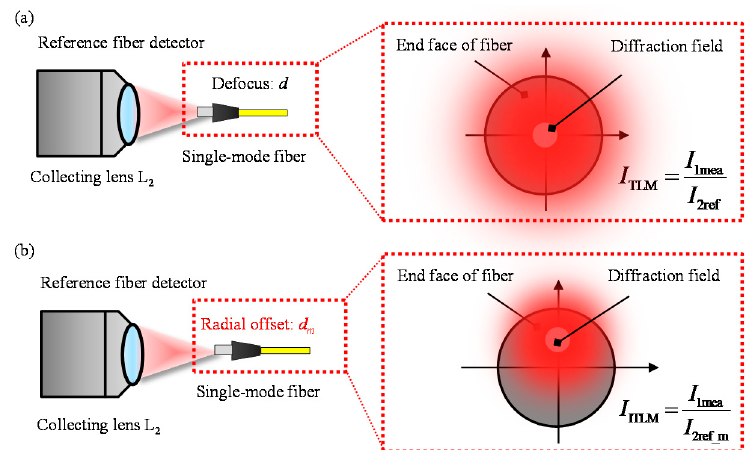
Figure 4. Schematic of the reference fiber detector settings by the proposed off-axis differential method and conventional differential method. ( a ) Schematic diagram of the reference fiber detector setting by the conventional differential method; ( b ) schematic diagram of the reference fiber detector setting by the proposed off-axis differential method.